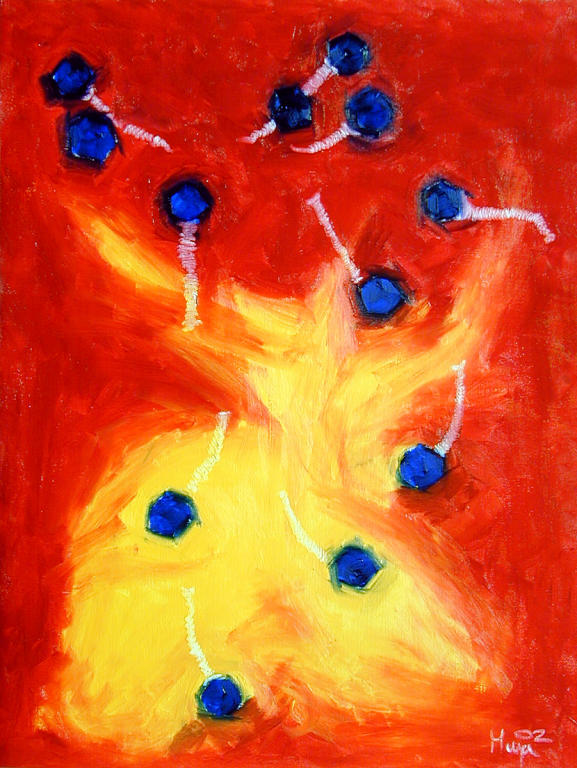
Viruses infecting the bacterium
Escherichia coli present very different life histories, which are probably constrained by a tradeoff between the decay rate of virus particles and the multiplication rate in the bacterial host. (Painting: “Phagedancer” by Stefanie Timmermann)